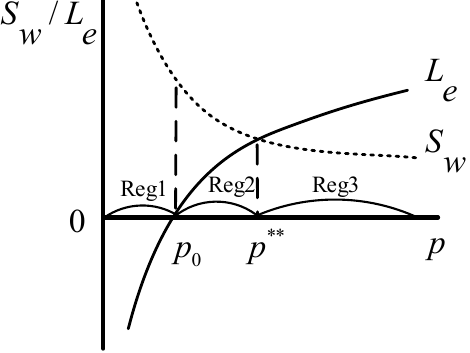
Figure 3. Schematic model of the Stackelberg game.